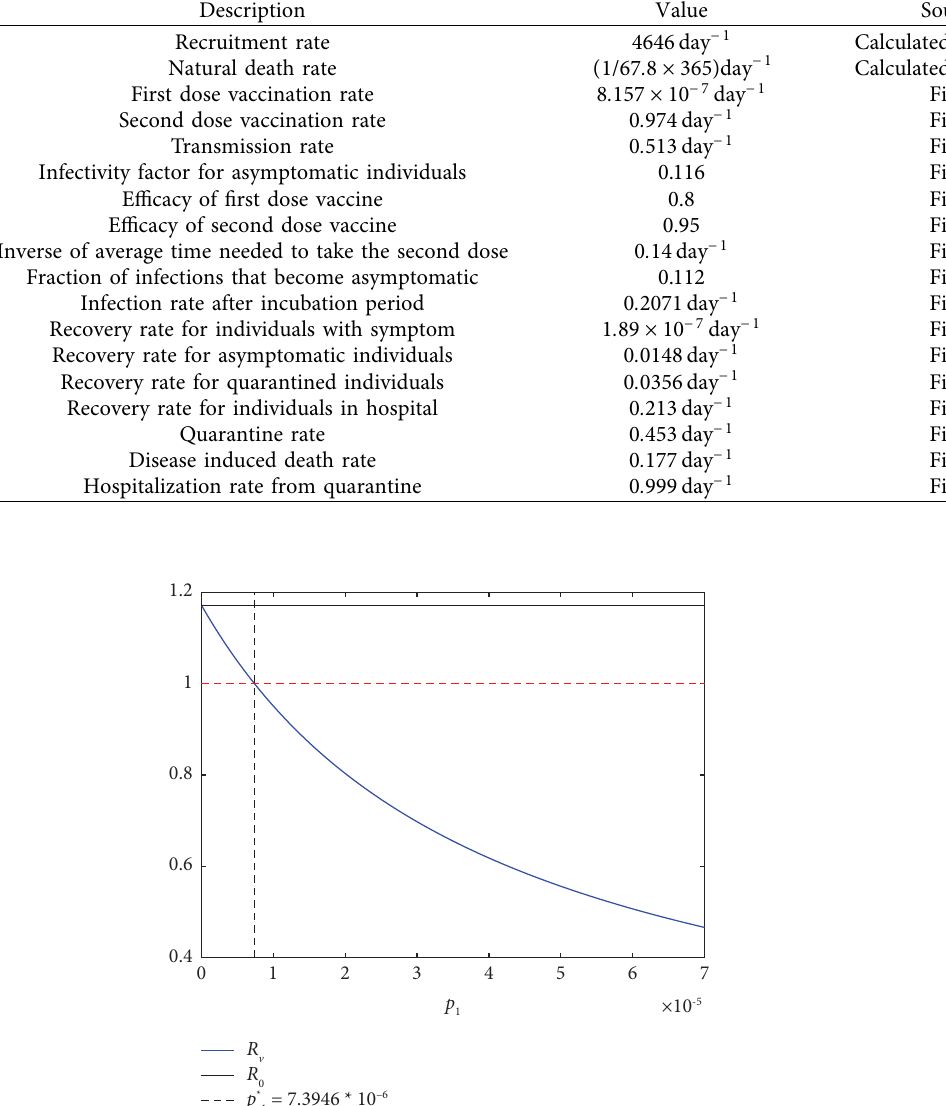
on the control reproduction number R v and the basic reproduction number R 1 is calculated using the parameter values in Table 1